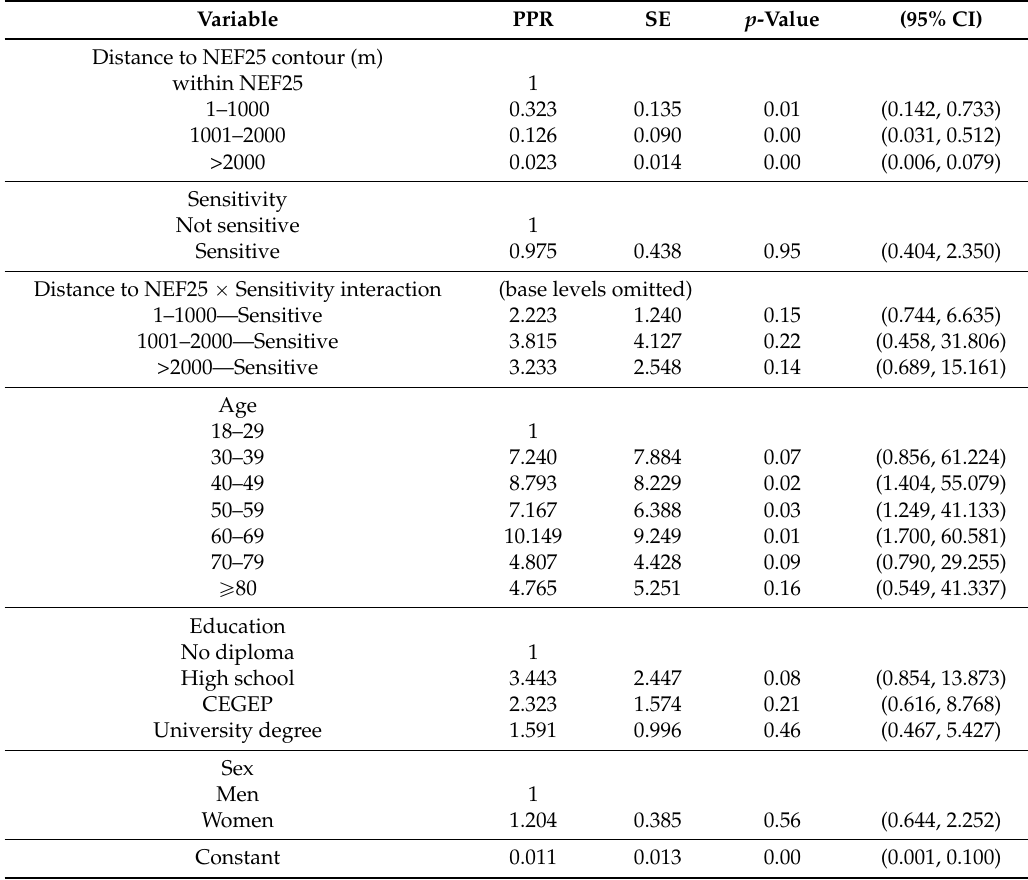
Table A6. Distance to the NEF25 contour and marginal proportions of sleep disturbance by airplanes in the weighted study sample adjusted for sensitivity to noise: regression model.